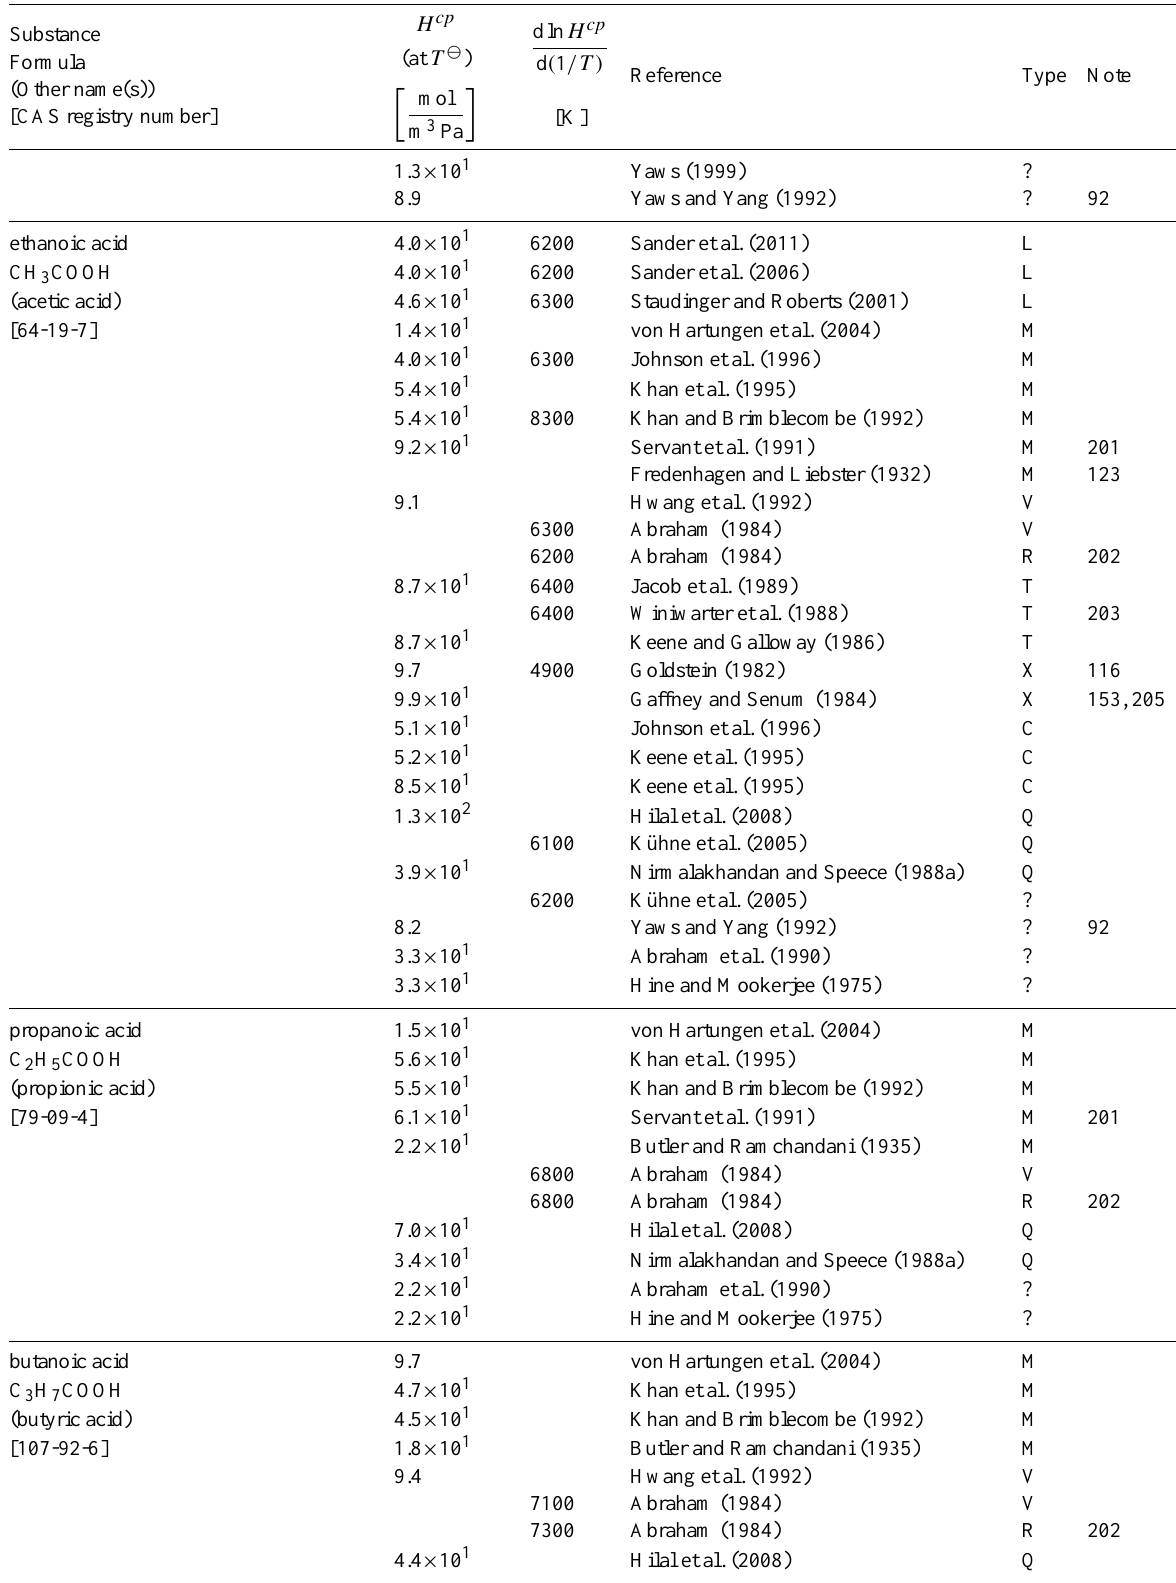
Table 6: Henry’s law constants for water as solvent